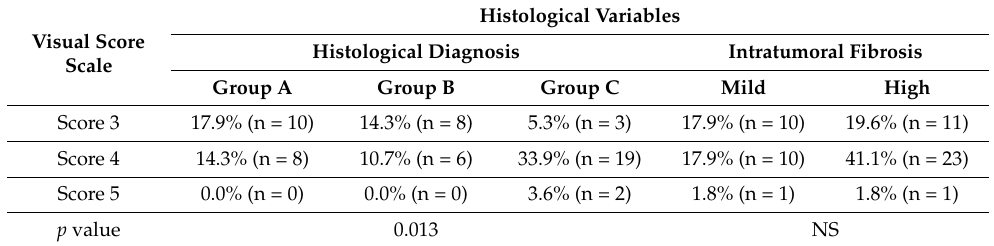
Table 2. Visual score scale of malignant mammary carcinomas according to their histopathological features.